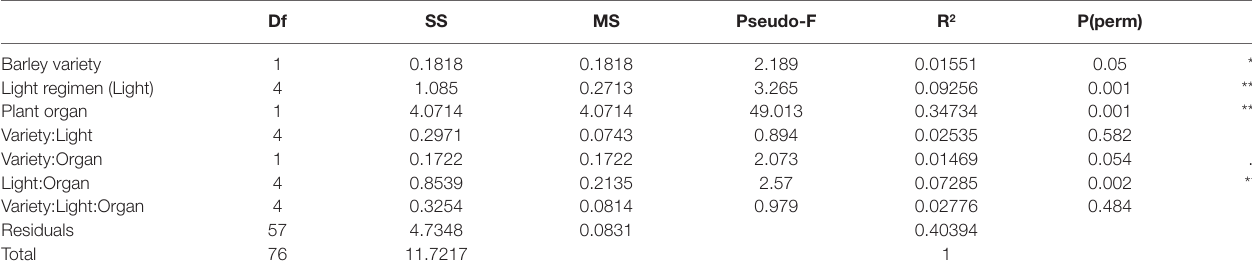
TABLE 1 | PERMANOVA results for the entire metabolomic data set. Df SS MS Pseudo-F